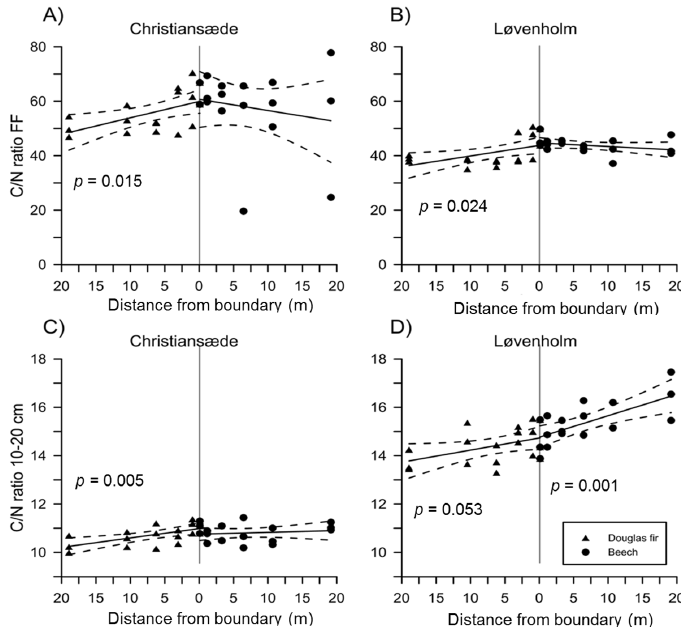
Figure 4. Response of the C/N ratio in the forest floor ( A and B ) and 10–20 cm layer ( C and D ) along transects from pure Douglas ‐ fir and beech stand conditions to the boundary at Christianssæde and Løvenholm.